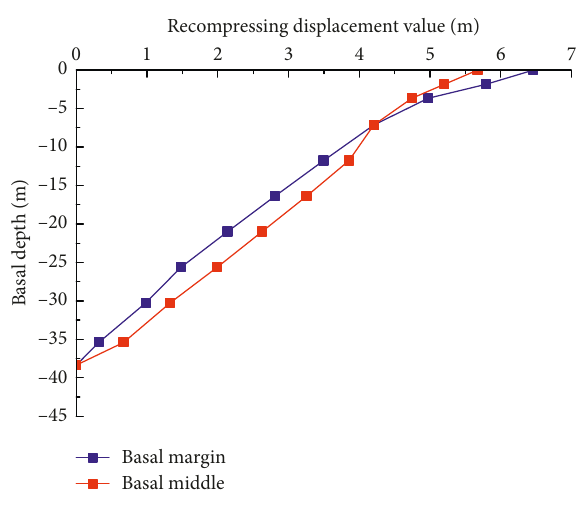
Figure 18: Recompression displacement along the depth